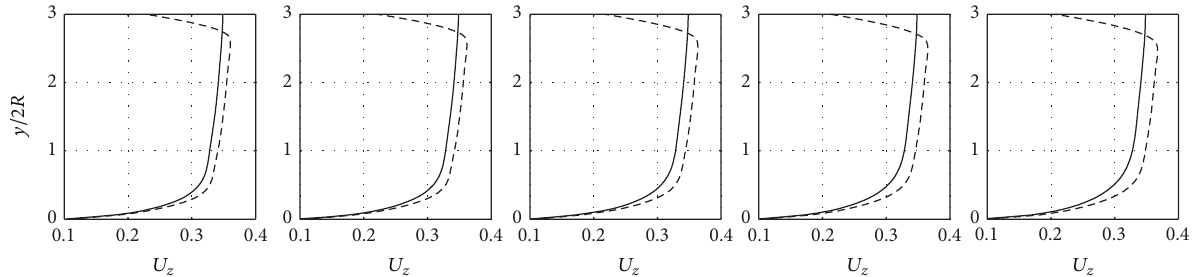
Figure 3: Velocity profile with no disc of the channel flow (solid line) and the duct flow (dashed line) at 24 m, 27 m, 31 m, 35 m, and 40 m from the